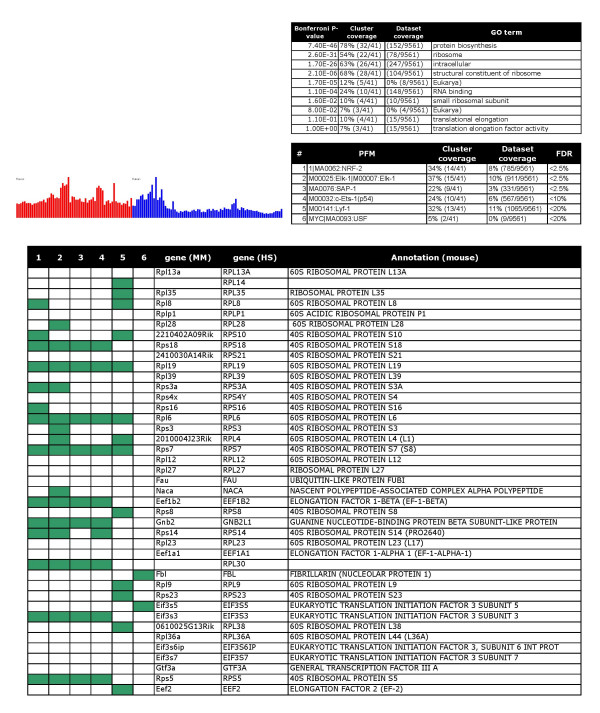
Ribosomal genes: Tables and charts are organized as in figure 2.